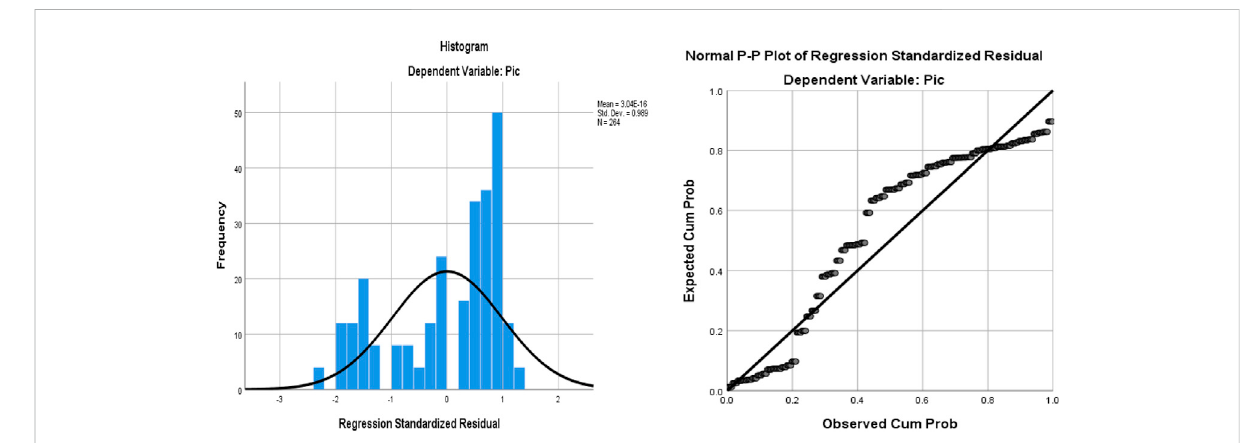
FIGURE 2 The histogram and the digrama Q – Plot fl owchart corresponding to the Pic dependent